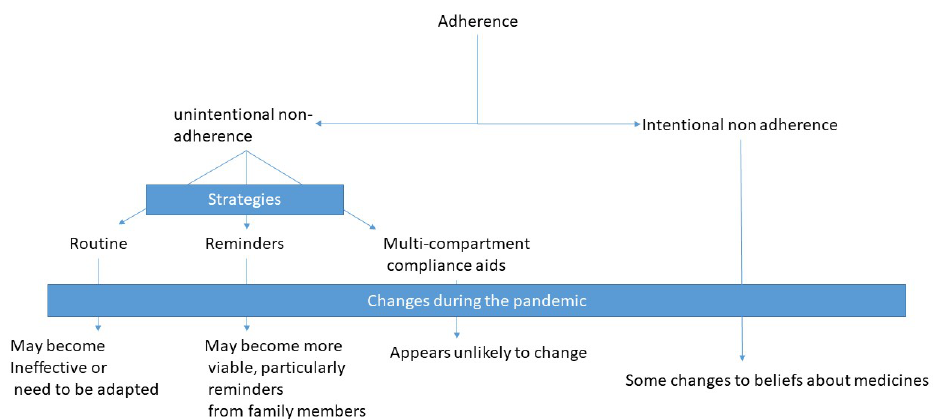
Figure 2. Summary of reported changes to challenges experienced with medication